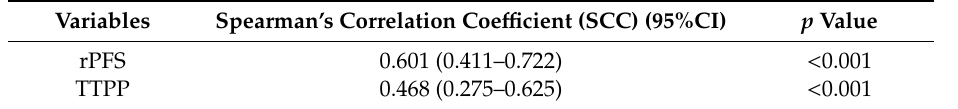
Table 4. Correlation of rPFS and TTPP with OS from the initiation of second line treatment.